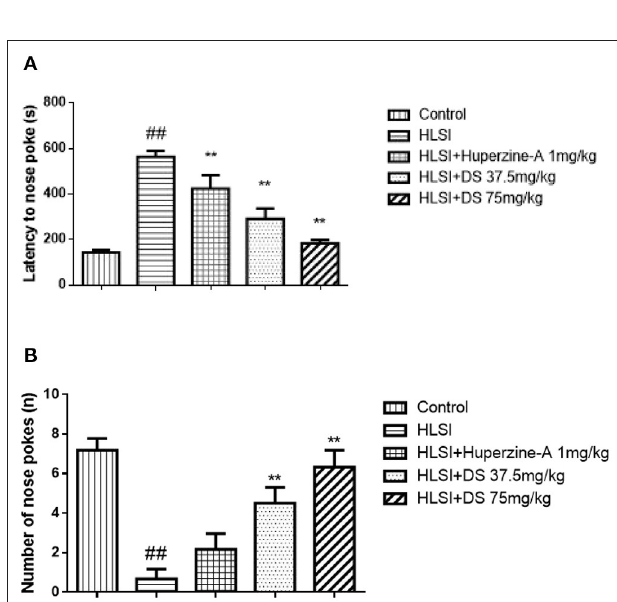
FIGURE 7 | The effects of DS on the novel object recognition test after HLSI in rats. The values are mean ± SEM ( n = 8–9) for the following: (A) latency of nose poke and (B) number of nose pokes. The symbols represent: ## p < 0.01 as compared with the control group; ** p < 0.01 as compared with the HLSI group.